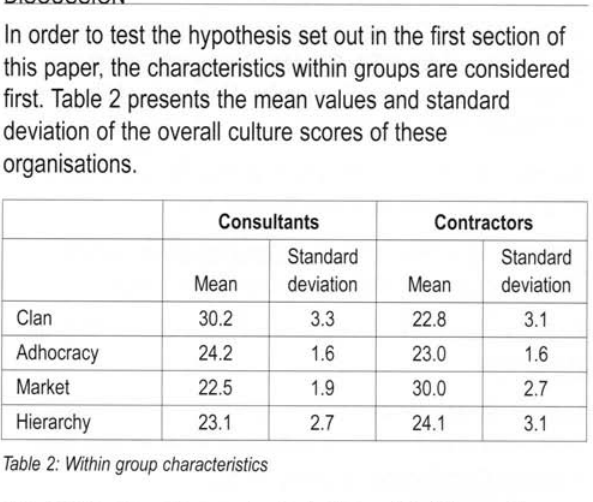
Table 2: Within group characteristics